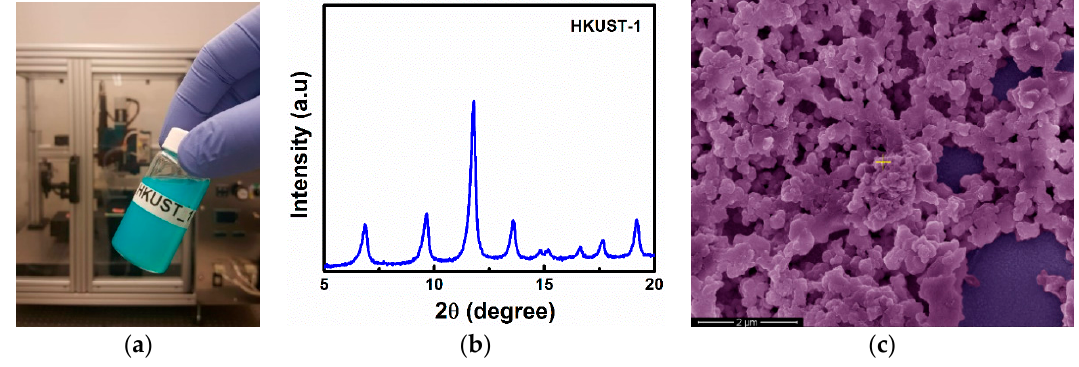
Figure 2. HKUST-1 metal-organic framework. ( a ) Photo of the MOF solution and the inkjet printer; ( b ) PXRD pattern and ( c ) Top-view SEM image of the HKUST-1 MOF thin film fabricated using the inkjet printing method.